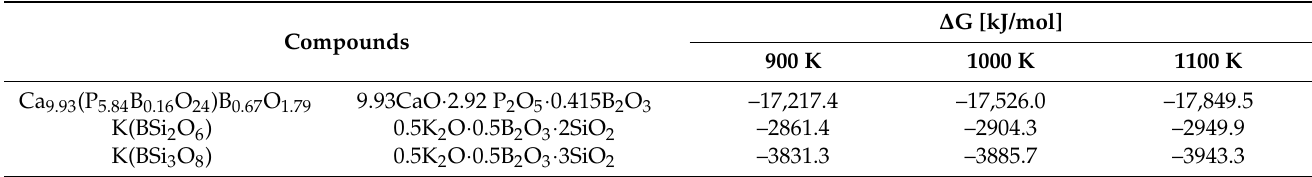
Table 5. Values of ∆ G for the formation of silicates and phosphates containing boron crystallizing in the analyzed